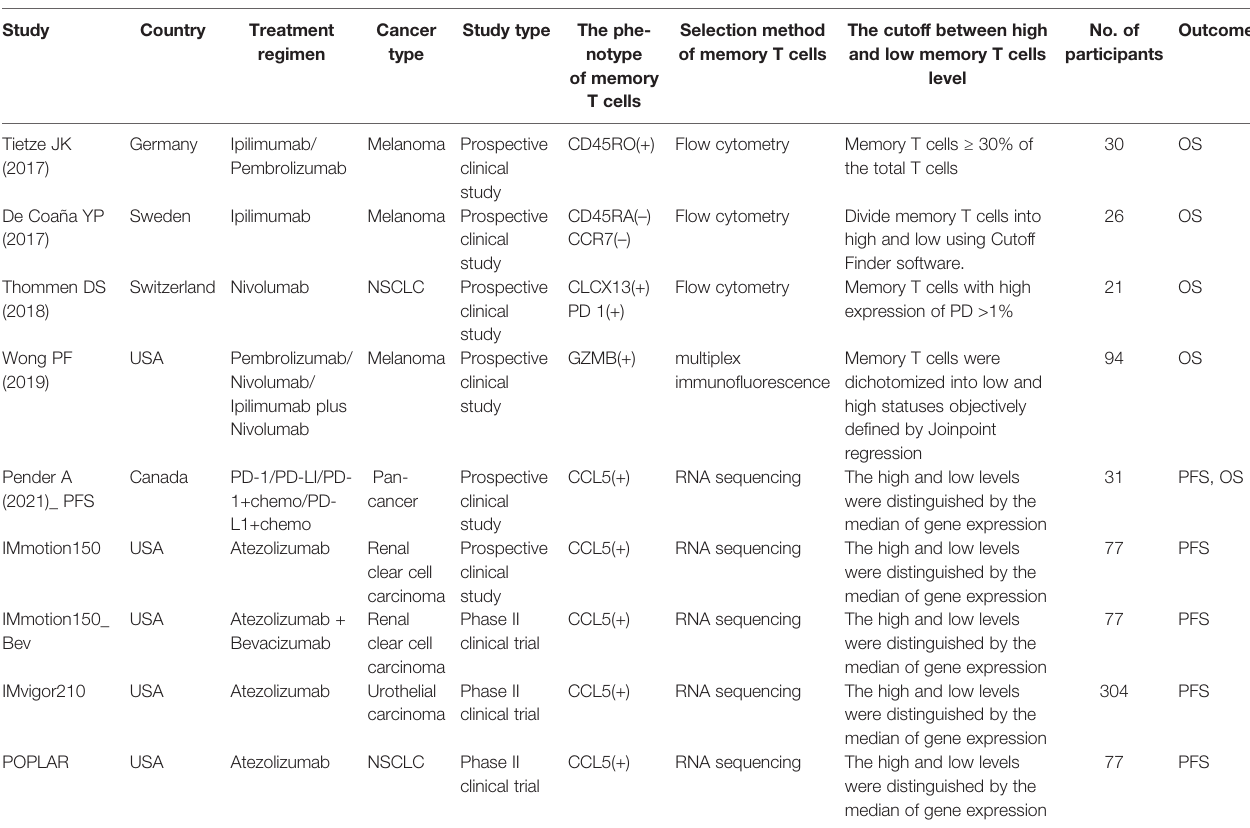
TABLE 1 | Characteristics of included